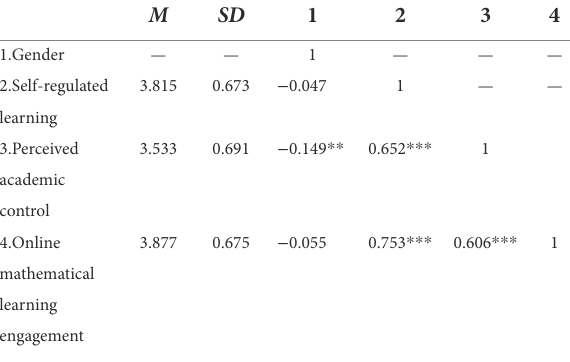
TABLE 2 Means (M), standard deviations (SD), and correlations ( N = 428) among the major variables in this study.